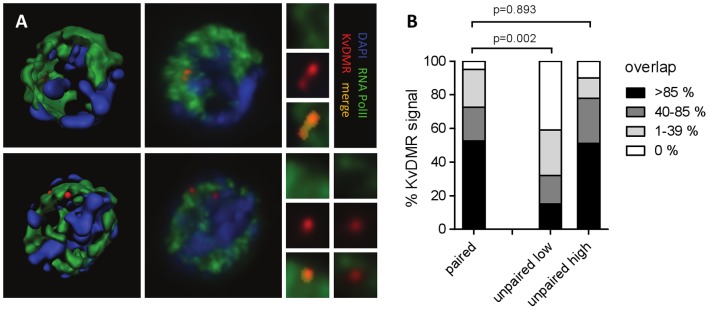
Pairing events occur in regions of active transcription.
A) 3D representations of image stacks from E13.5 liver cells. Red: KvDMR DNA FISH signals, green: immunostaining for elongating RNA polymerase II, blue: DAPI counterstain. Top panels show a nucleus with paired signals, bottom panels show a nucleus with unpaired signals. Left panels: 3D rendered reconstruction of immuno-FISH data, middle panels: corresponding unrendered images, right panels: blow-up of DNA FISH signals and their colocalisation with RNA PolII immunostain. At this resolution regions of high PolII activity can be clearly defined but do not present as discrete transcription factories. B) Quantification of KvDMR signal overlapped by RNA PolII signal. Differences were assessed by t-test. For unpaired alleles, one is generally located in areas rich in RNA PolII (unpaired high) while the other one is mostly found in areas devoid of RNA PolII (unpaired low). Paired alleles are nearly always found in regions of active RNA PolII.